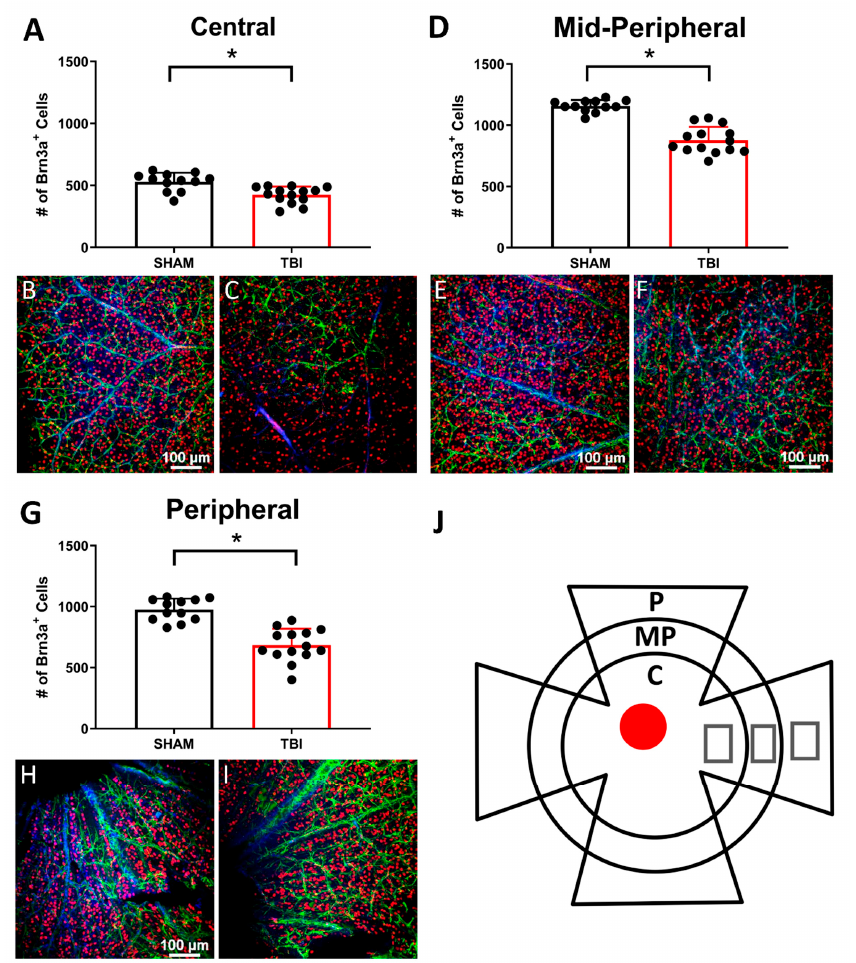
Figure 5. Retinal ganglion cell immunohistochemistry. Retinas of sham and TBI mice were immunolabeled with Brn3a (red), GFAP (green), and DAPI (blue). Brn3a-labeled cells were counted in 3 zones of the retina ( A , D , G ) Representative photomicrographs taken at 20× magnification of sham ( B , E , H ) and TBI/iTON mice ( C , F , I ). ( J ) Depiction of whole-mounted retina with grey squares representing photo locations. Retinas were divided into three regions: peripheral (P), mid-peripheral (MP), and central (C). The red circle indicates the location of the optic nerve. Scale bar indicates 100 μ m and is the same for all images, * p < 0.001.